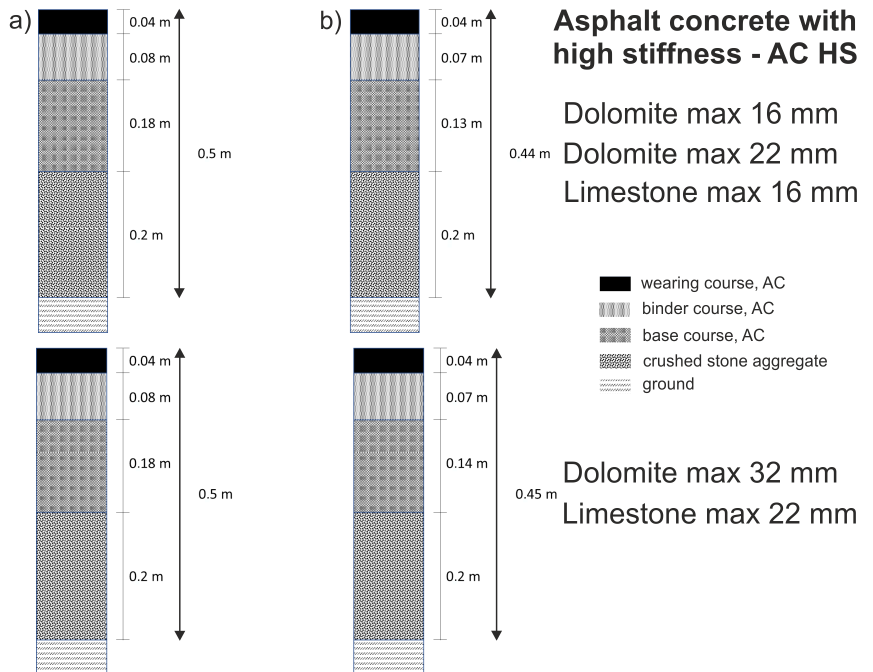
Figure 9. Construction of road structure KR 7 for various types of asphalt concrete (AC): ( a ) according to the GDDKiA Catalogue; ( b ) according to the studies presented herein (compare with Table 5). 16, 22, and 32—upper limit of aggregate in millimeters, lower limit is 0 mm. Table 5. Fatigue durability and thickness of road surface structure: 1 —according to GDDKiA Cata- logue; 2 —according to the studies presented herein (see Figure 9).